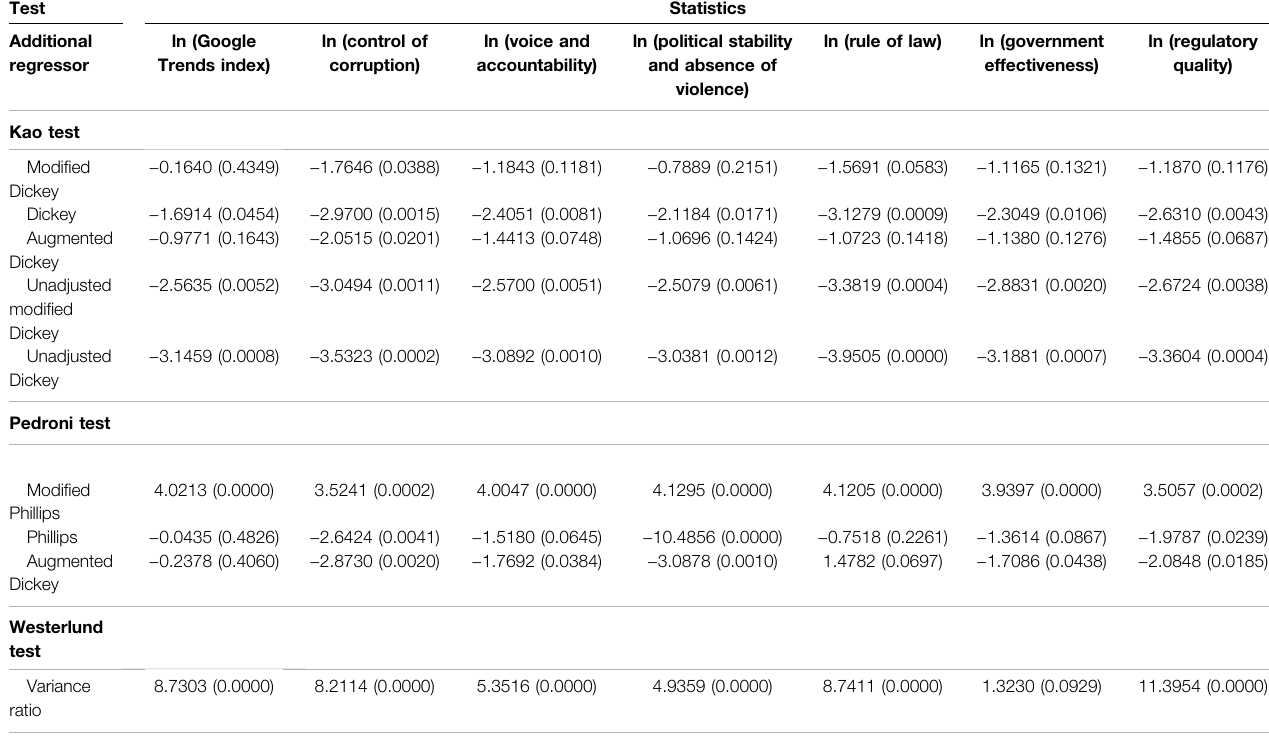
TABLE 4 | The results of cointegration tests ( p -values in brackets).